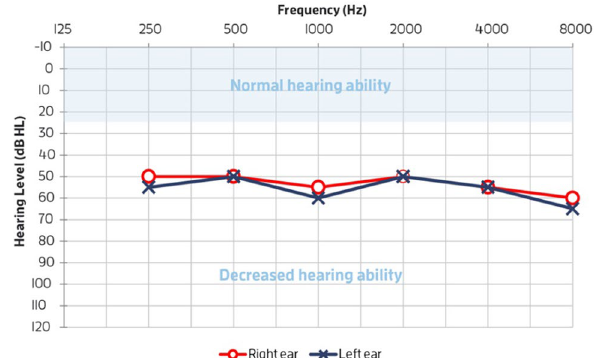
Figure 1. Audiogram to show the hearing ability of left and right ears. X left ear, O right